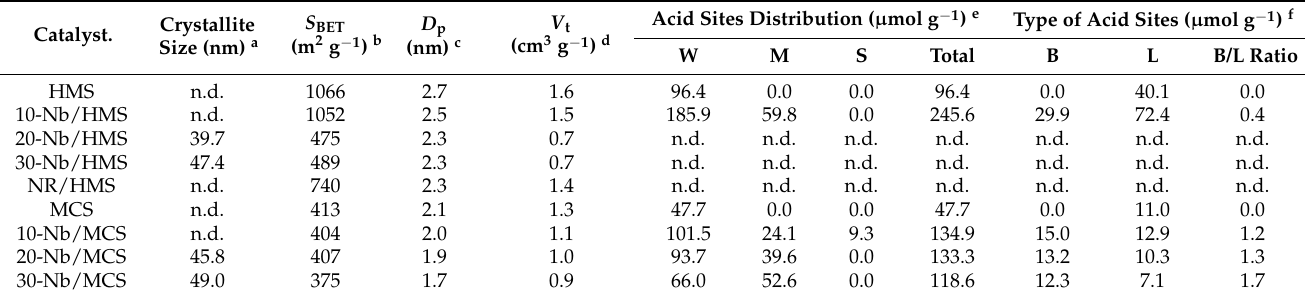
Table 1. Physicochemical and acid properties of HMS and MCS with different Nb loading amount.